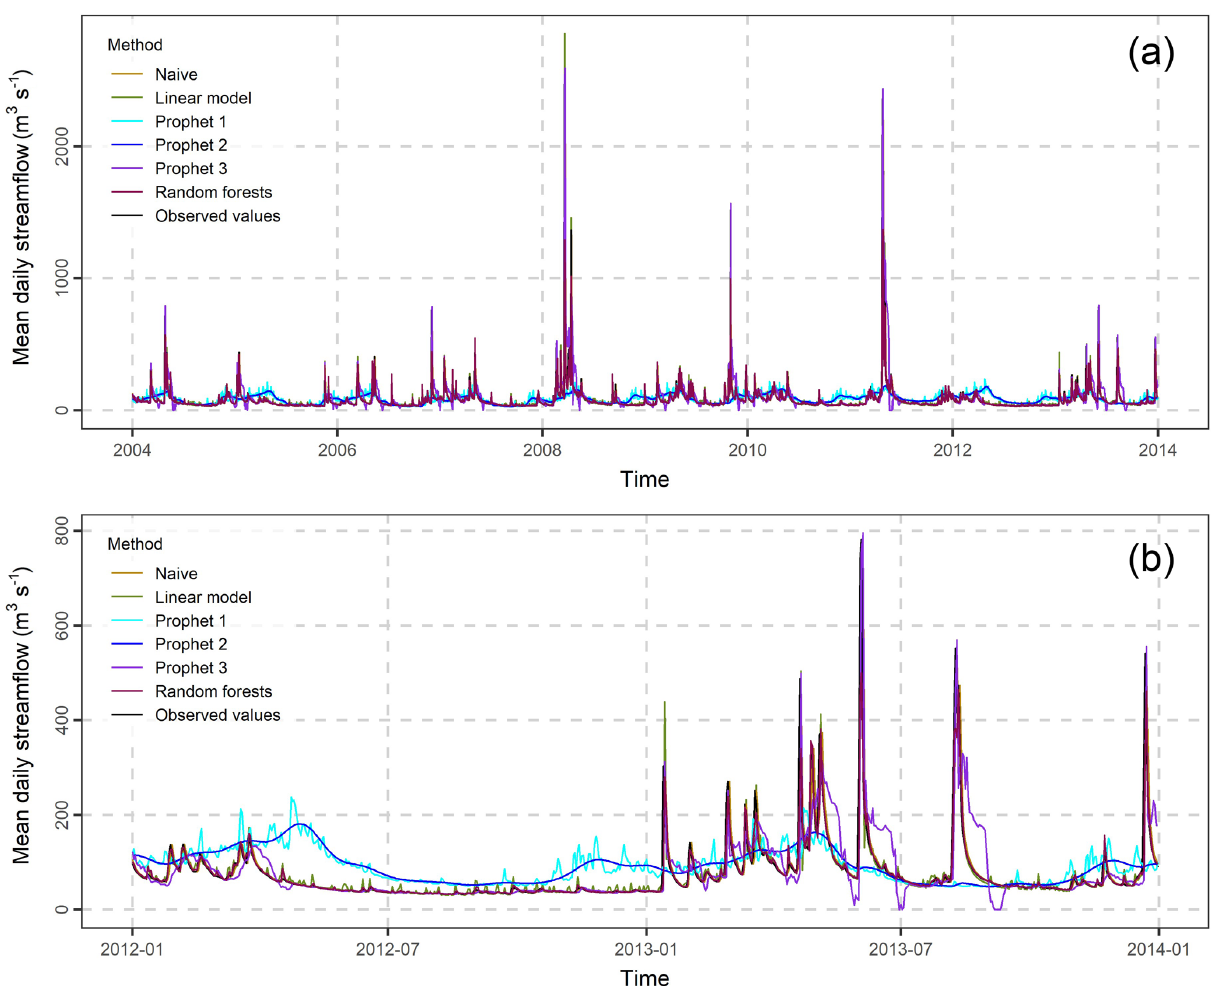
Figure 3. 1-step ahead forecasts of the Current river daily streamflow in the periods 2004–2013 (a) and 2012–2013 (b)